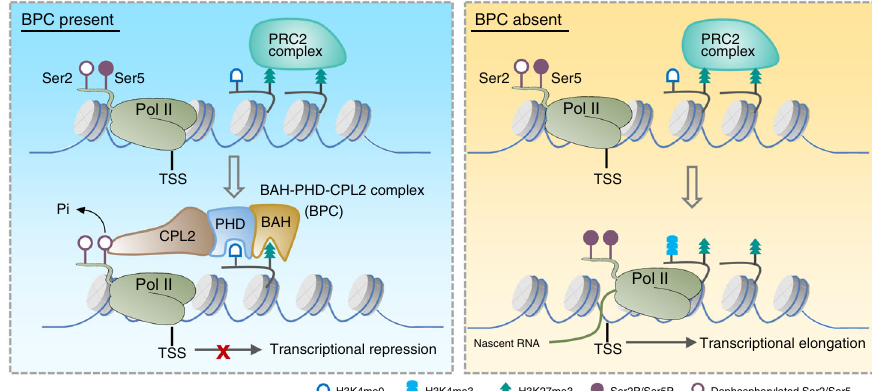
Fig. 8 A working model of the BPC complex-mediated transcription repression. When BPC is present, AIPP3-BAH, and AIPP2/PAIPP2-PHD motifs recognize H3K27me3, which is deposited by PRC2 complex, and unmodi fi ed H3K4 around the TSS, respectively. Then, the BAH – PHD histone reader module recruit CPL2 to dephosphorylate Pol II at the fi fth Ser of CTD, thereby repressing the transcriptional initiation and subsequent elongation of Pol II. When BPC is absent, active H3K4me3 mark is deposited. Pol II CTD-Ser2 and -Ser5 residues can be phosphorylated sequentially, leading to release of Pol II from initiation to elongation